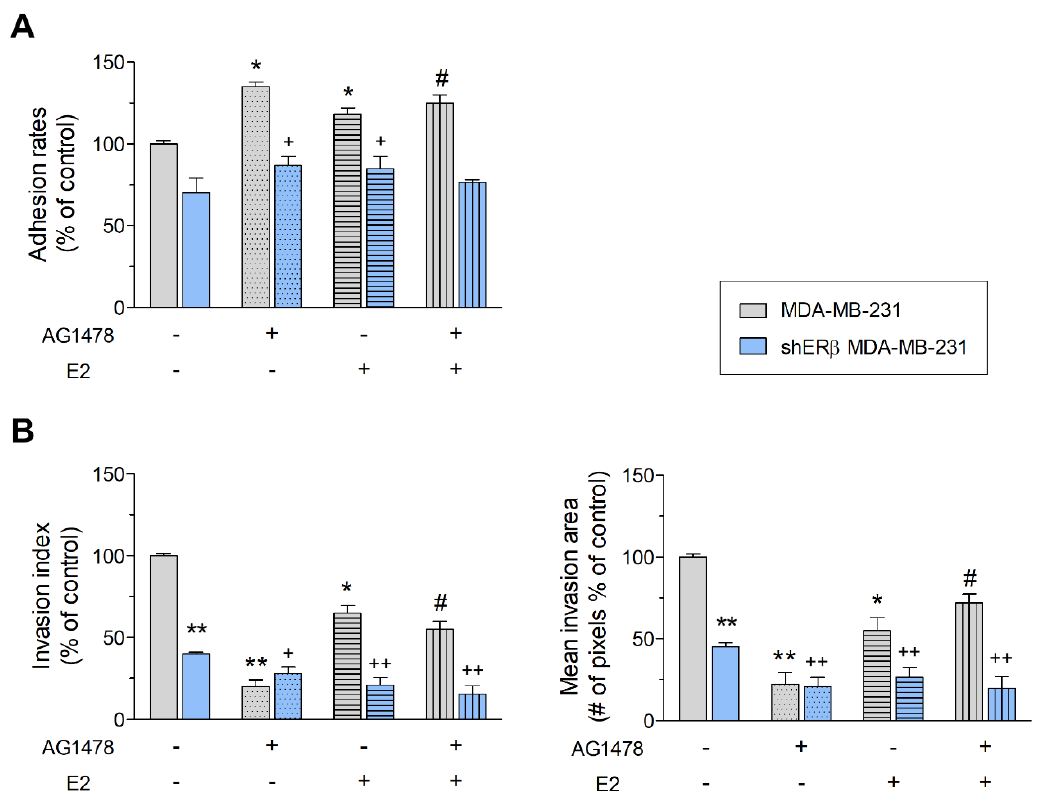
Figure 2. EGFR/ERβ axis regulates functional properties of MDA-MB-231 and shERβ MDA-MB-231 breast cancer cells. ( A ) Collagen type I adhesion. ( B ) Cell invasion in collagen type I matrix. Treatments with AG1478 (2 μM) and/or E2 (10 nM) were performed for 24 h prior in MDA-MB-231 and shERβ MDA-MB-231 cells. Each bar represents mean ± SD values from triplicate samples. Statistically significant differences are indicated accordingly: * p < 0.05 and ** p < 0.01 compared to MDA-MB-231 control cells; + p < 0.05 and ++ p < 0.01 compared to shERβ MDA-MB-231 control cells; and # p < 0.05 compared to E2-treated cells.